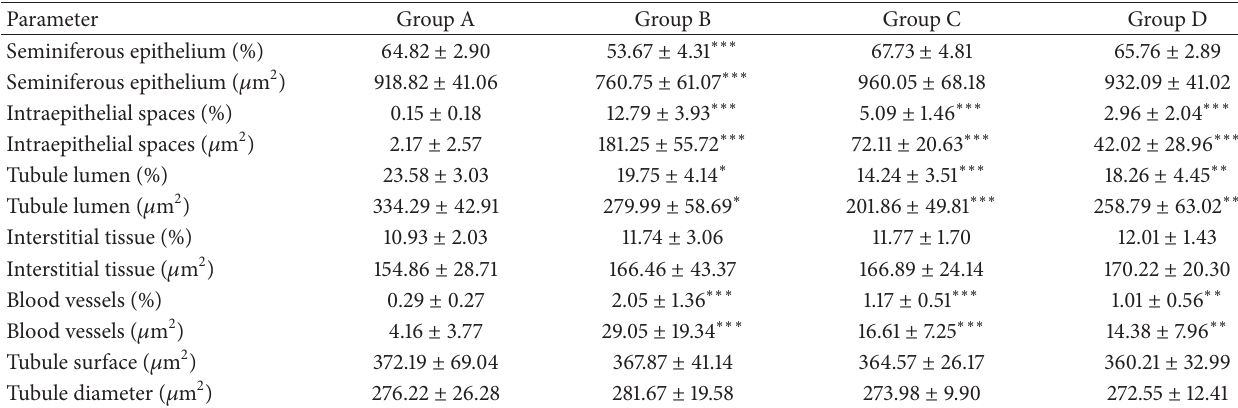
Table 2: Morphometric testicular